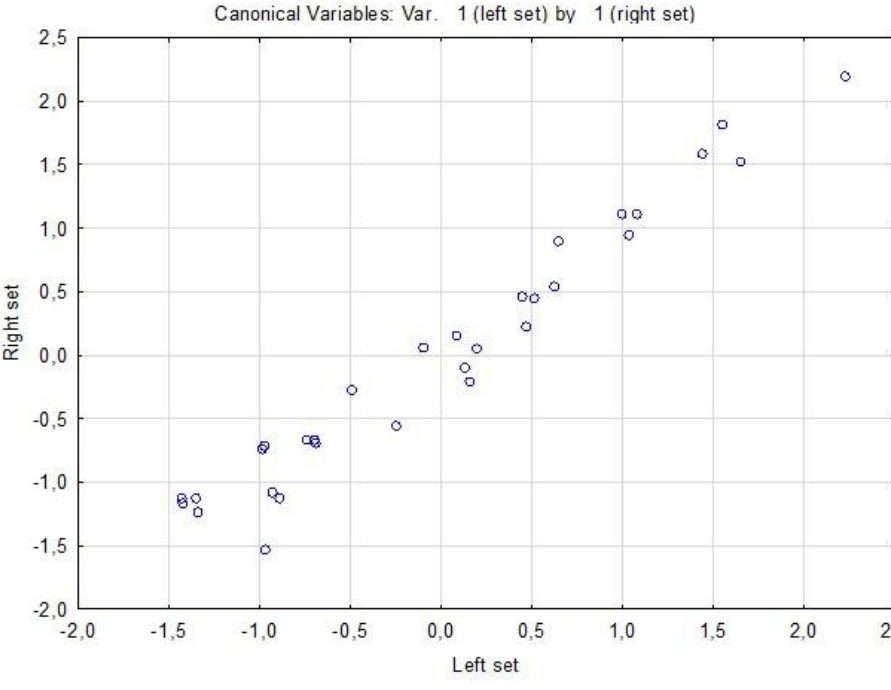
Figure 5. Scatter Plot of Canonical